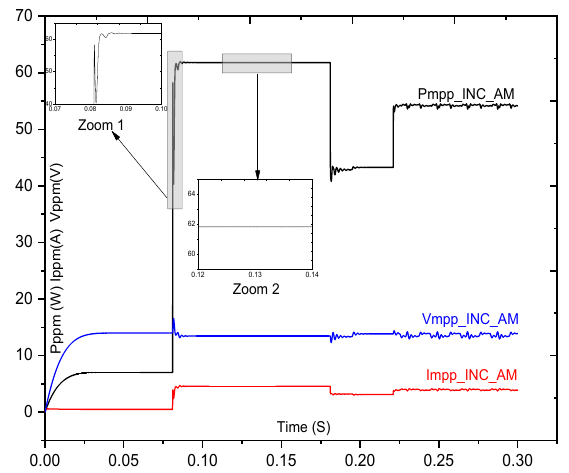
Figure 13: Response in terms of pv module power in the case of the "INC_AM" algorithm